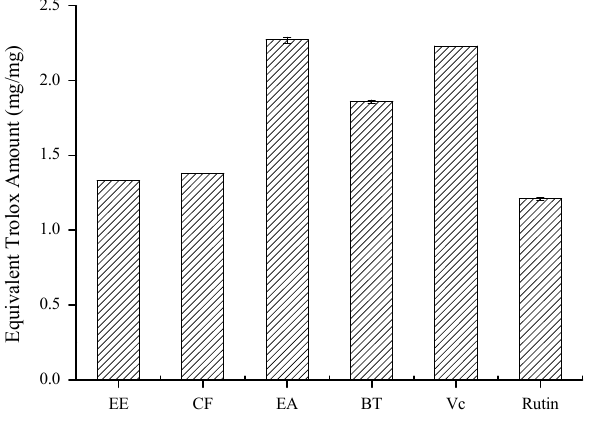
collected in Anhui, China (EE, CF, EA, BT represent the ethanolic extract, chloroform, ethyl acetate and n -butanol fractions, respectively; Vc and rutin were used as positive